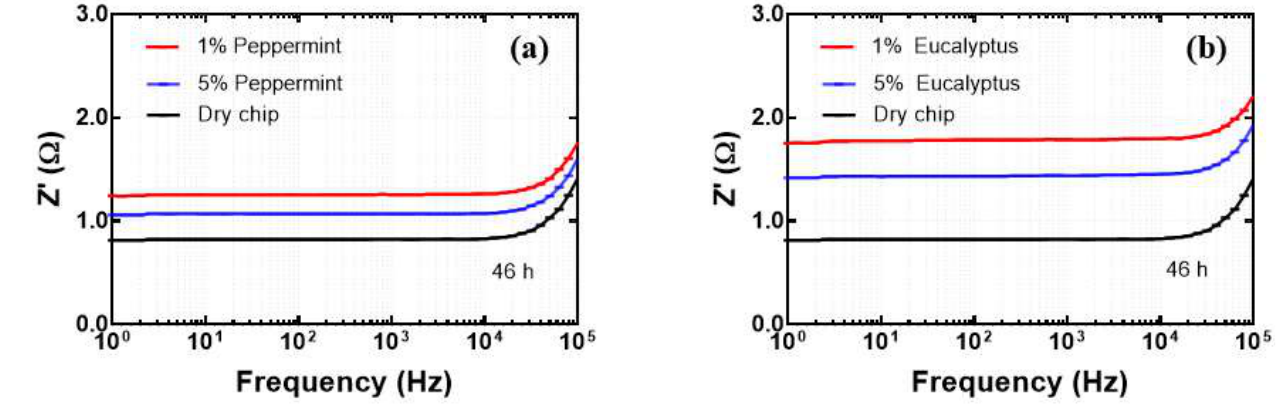
Figure 5. Electrical resistance of fabricated microfluidic chip for 1% and 5% concentrations of ( a ) peppermint and ( b ) eucalyptus EOs, after 46 h of exposure.